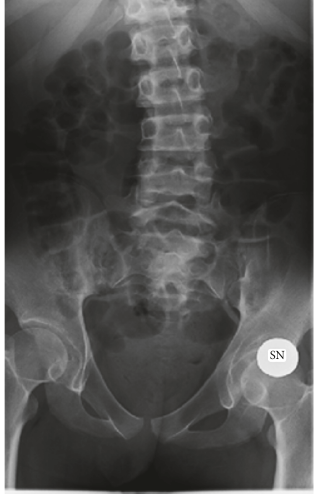
Figure 2: Dorsal